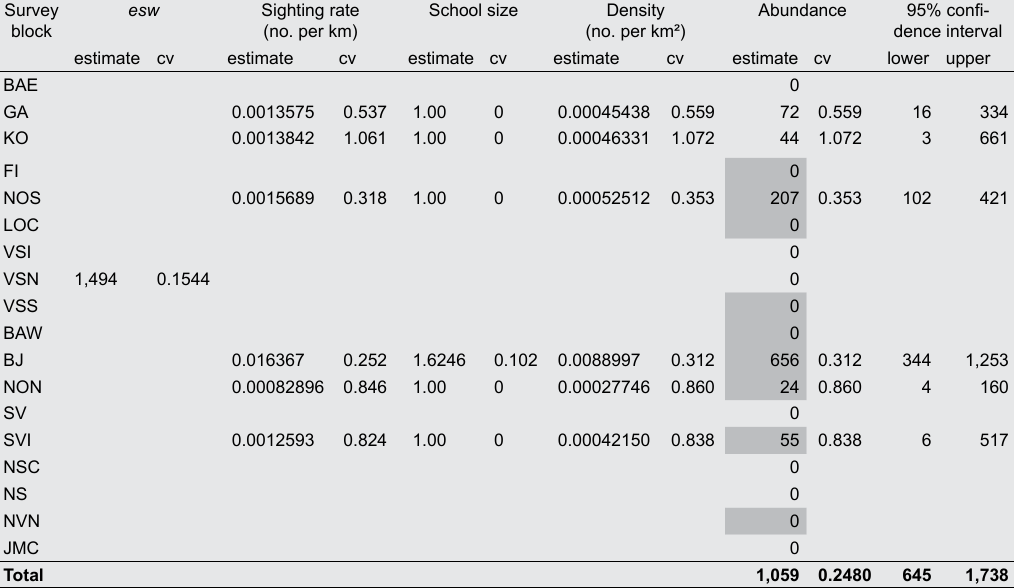
Table 8. Estimated abundance for humpback whales for the shipboard survey in 1995, based on the combined data from plat- forms 1 and 2. Estimates that include single-platform effort are shaded. Survey block estimate cv